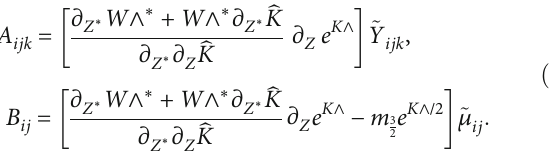
Figure 2: After the end of in fl ation, as χ approaches minimum near zero, Polonyi fi eld Z settles down to minimum at Z positive Polonyi potential is obtained for the parameter values α = 20 , μ from the requirement of getting PeV scale soft SUSY breaking